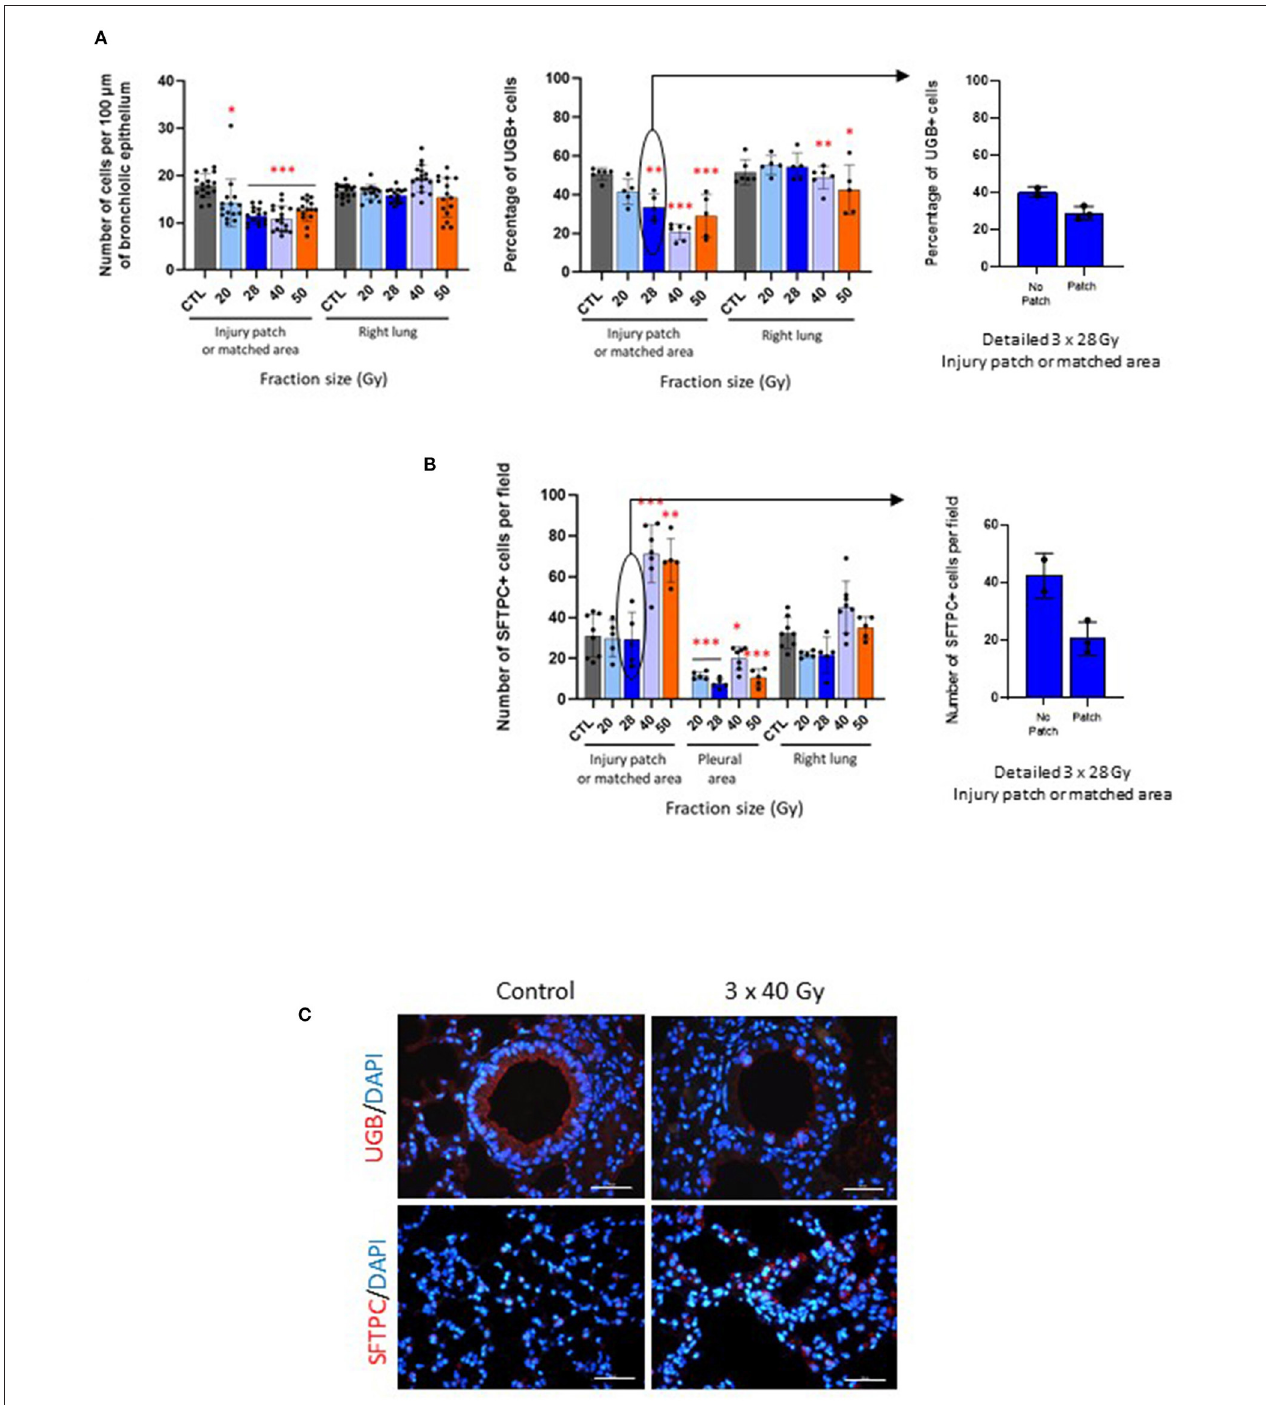
FIGURE 3 | Fibrosing schedules induce club cell loss and increased numbers of type II pneumocytes. (A) Number of cells per 100 µ m of bronchiole epithelium (left-hand graph) and percentage of UGB-positive cells (middle graph) measured in the injury patch or matched area and right lungs in control and focally irradiated tissues 6 months after 3 × 20, 28, 40 or 50Gy. Right-hand graph shows detailed data for 3 × 28 Gy-exposed mice with or without visible patch. * p < 0.05; ** p < 0.01; *** p < 0.001 compared to respective control groups. n = 5 or 6 per group, except for number of cells: 1 point = 1 bronchiole. (B) Number of SFTPC-positive cells per field counted in the injury patch or matched area, far from the patch near the pleural area and in the right lung 6 months after 3 × 20, 28, 40 or 50Gy and in control tissue (left-hand graph). Right-hand graph shows detailed data for 3 × 28 Gy-exposed mice with or without visible patch. * p < 0.05; ** p < 0.01; *** p < 0.001 compared to respective control groups. n = 5–8 per group. (C) Images of uteroglobin and pro-surfactant protein C immunostainings (UGB, marker of club cells and SFTPC, marker of type II pneumocytes, respectively) in control tissues and after 3 × 40Gy schedule as an example. Scale bar represents 100 µ m.